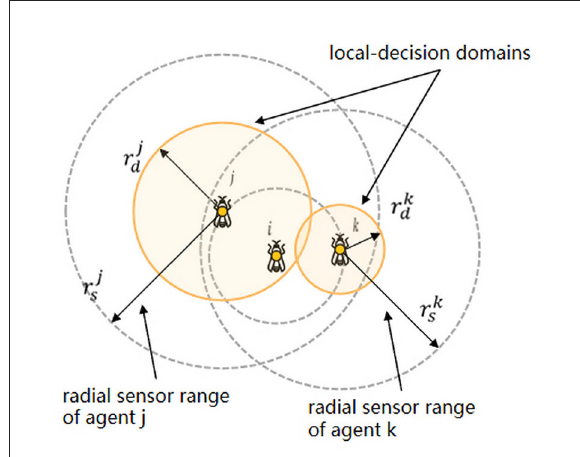
FIGURE4 Glowworm i is in the sensor range of (and is equidistant to) both j and k . However, j and k have different local-decision domains,